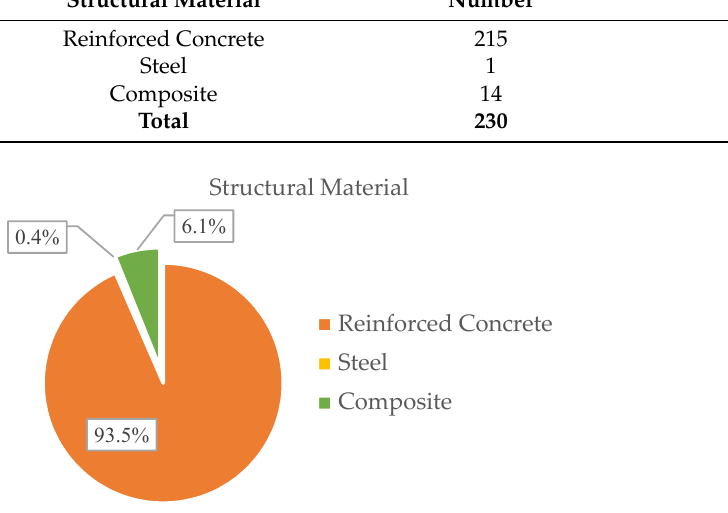
Figure 9. Analysis of selected tall buildings by structural material.